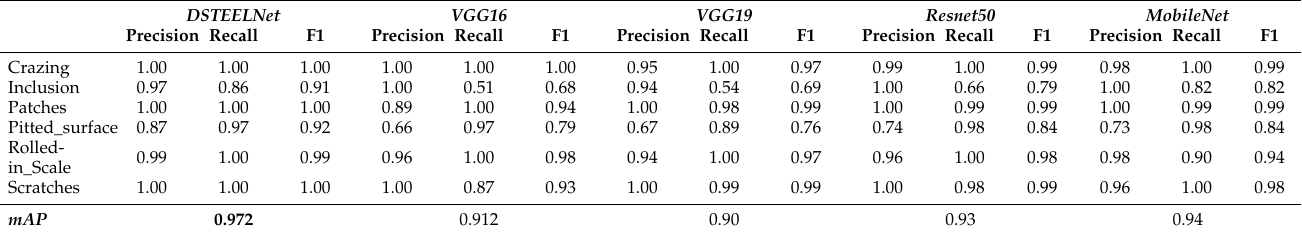
Table 3. Detection Results on GNEU